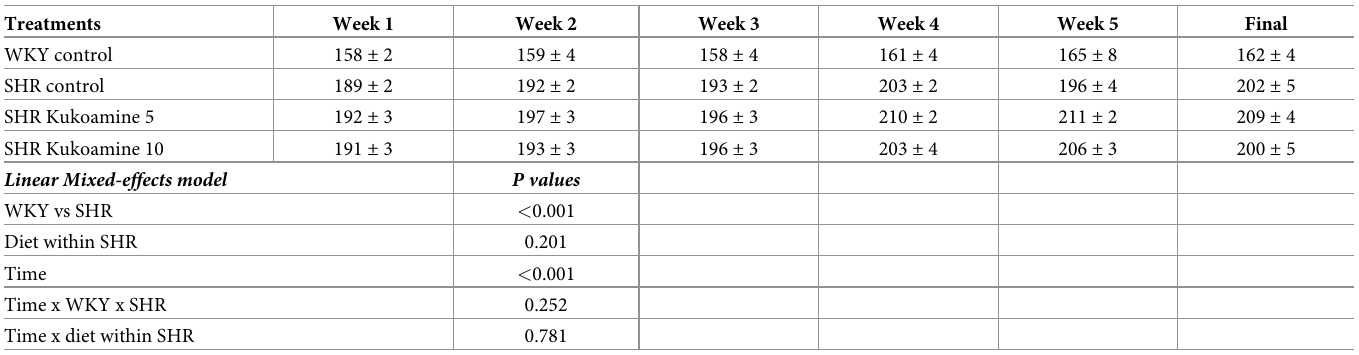
Table 4. Weekly mean systolic blood pressure (BP) (mm Hg) of the rats on the experimental treatments 1 .